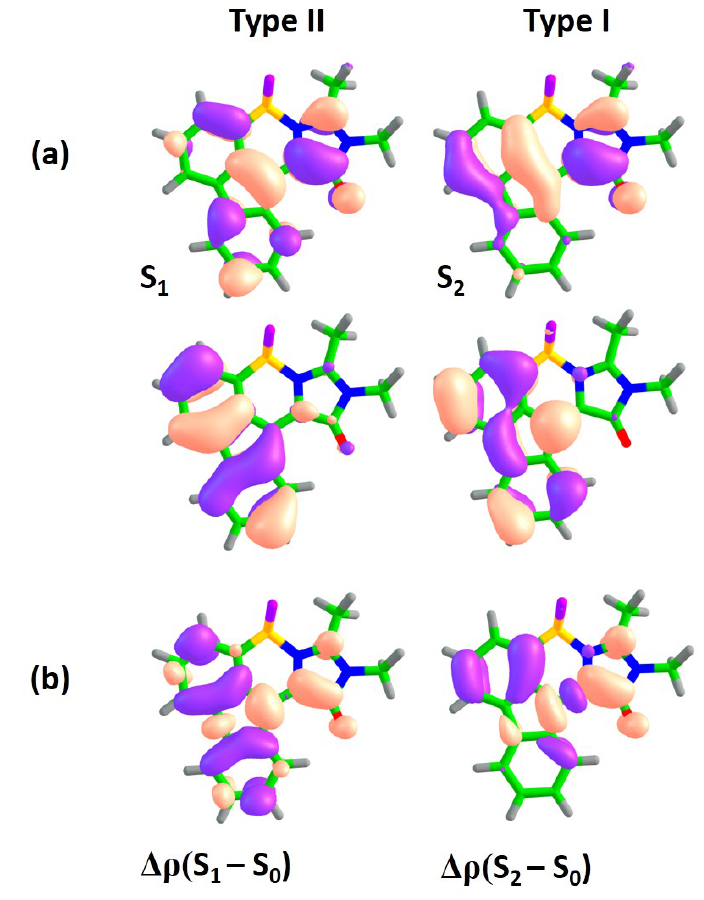
Figure 3. XMCQDPT2 natural orbitals actively involved in the S 0 –S 1 and S 0 –S 2 transitions ( a ) and the corresponding differential electron densities ∆ ρ ( b ) for compound 1A . For each state, the excitation is directed from the lower orbital to the higher orbital. The color code stands for negative and positive ∆ ρ values depicted in blue and red,